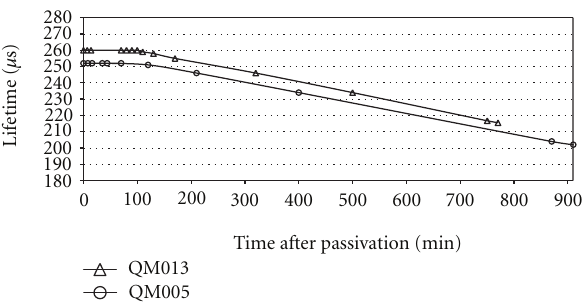
Figure 4: Comparison of the temporal stability of chemical pas- sivation between QM005 and QM013.